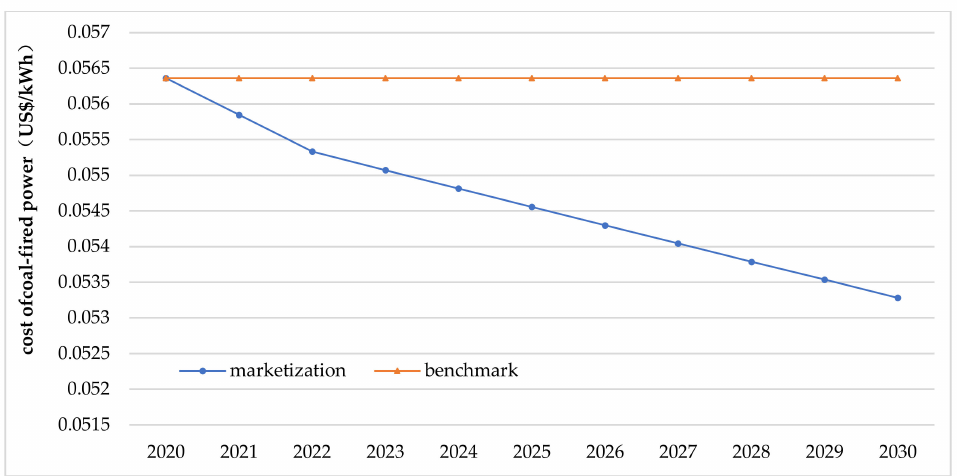
Figure 7. Coal-fired power cost under market-oriented mechanism and benchmark price.